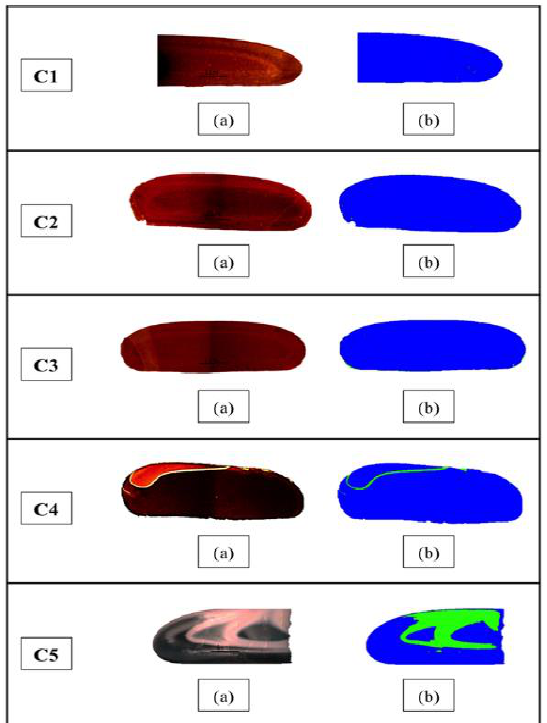
Figure 8. ( a ) Cross sectional images of C-series mould powders. ( b ) Threshold analysis of C-series mould powder (crystal parts in green and glassy parts in blue).